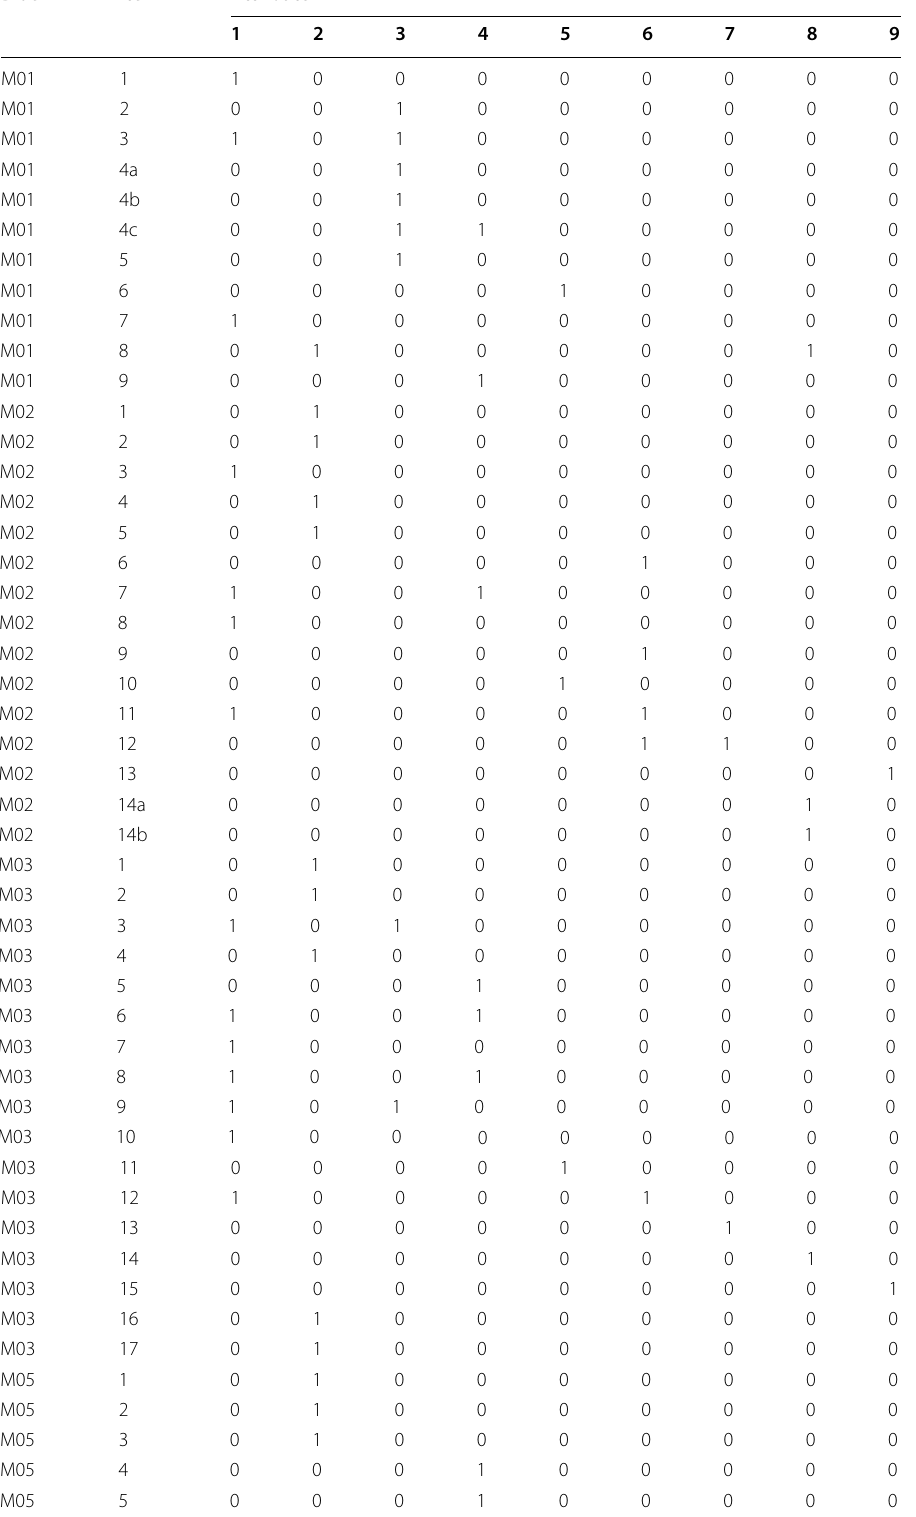
Table 14 Q-matrix refined by the stepwise method: Tunisia